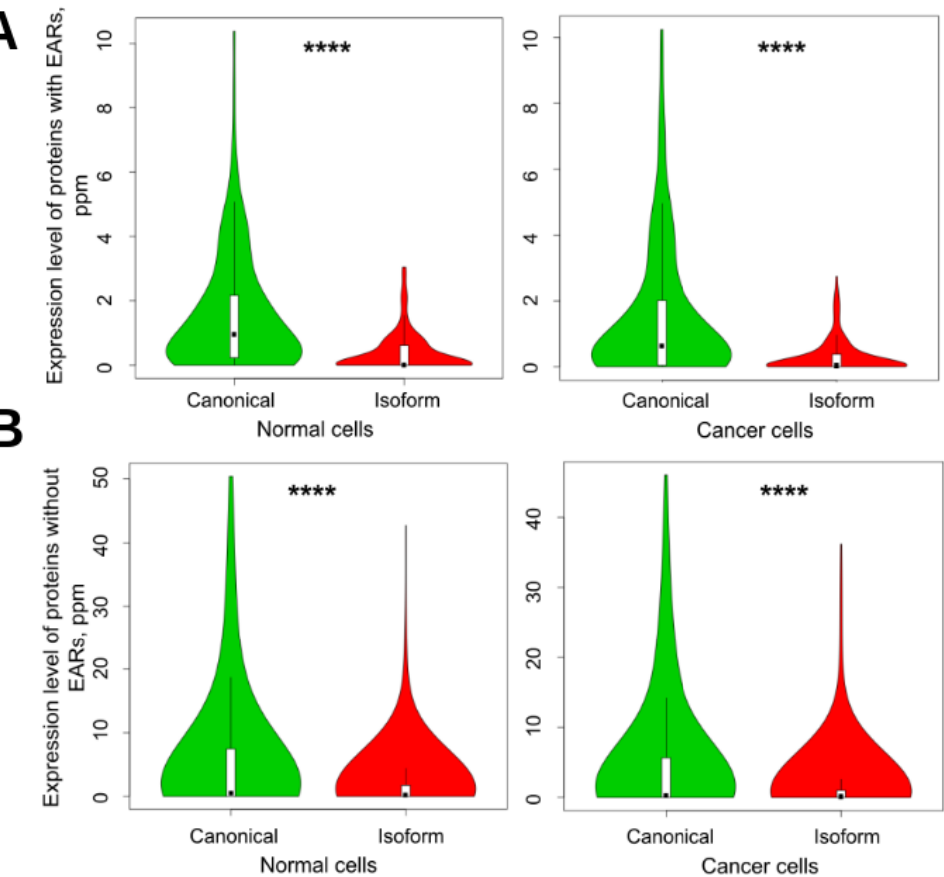
Figure 5. Violin plots of expression of canonical proteins and their isoforms in normal and cancer cells. ( A ) EAR-containing proteins and ( B ) non-EAR-containing proteins. EARs were predicted by using the ArchCandy program. Mean levels of expression for EAR-containing canonical proteins and isoforms in normal cells were 1.565 and 0.386, respectively, and in cancer cells, 1.490 and 0.306. For non-EAR-containing proteins, these values were 5.784, 1.773, and 4.984, 1.499, respectively. In accordance with t -test, all results were significant, with p -values of less than 10 −1 3 . **** means significant difference with p-value < 0.0001.